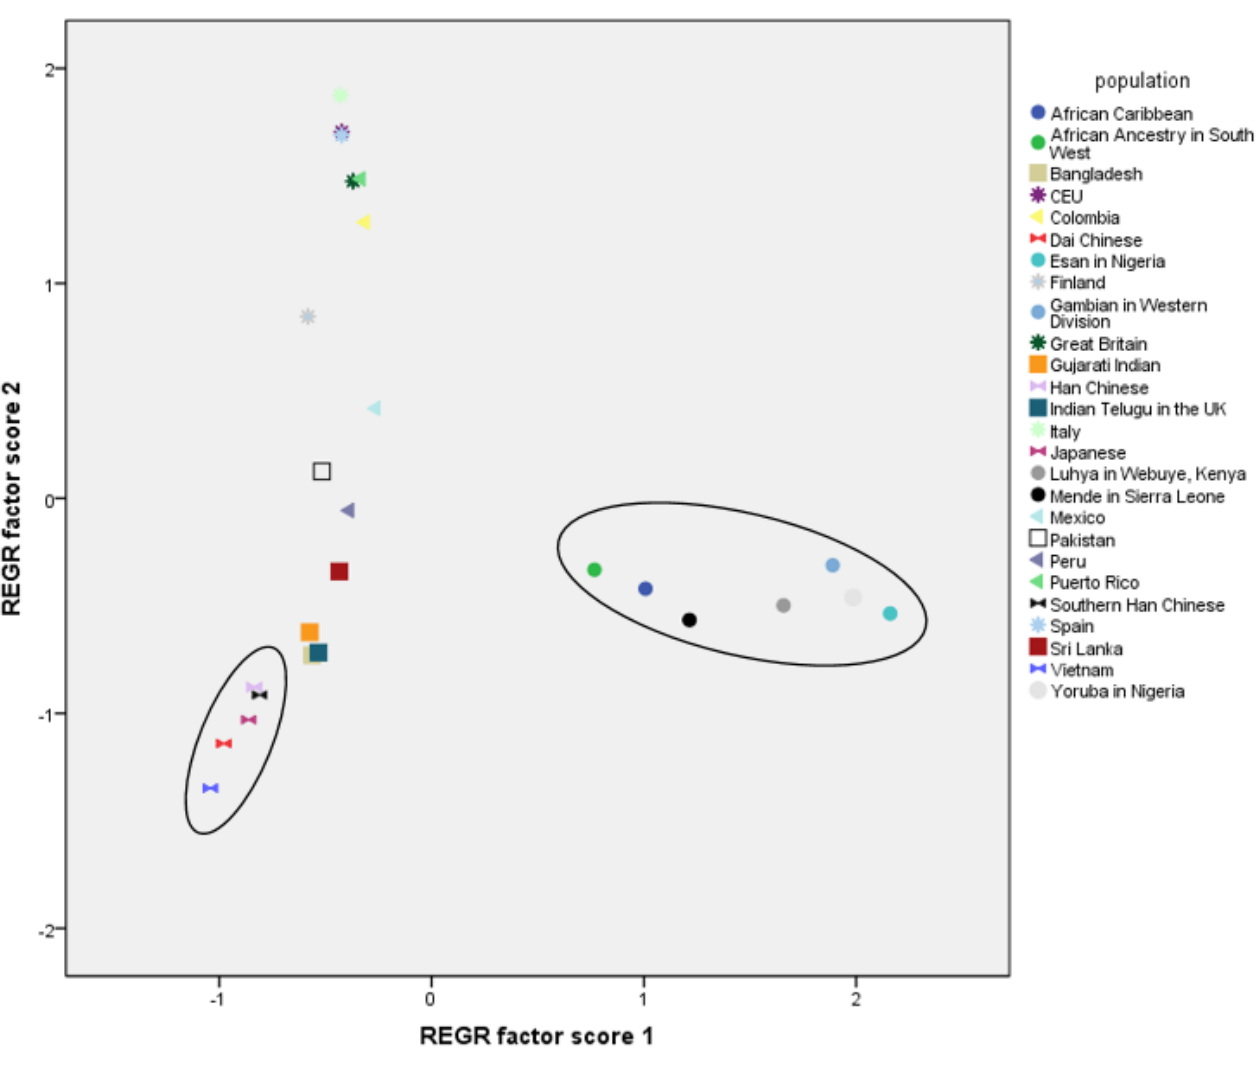
Figure 3. Principal component analysis (PCA) based on CYP2D6 haplotypes present in 26 world populations.